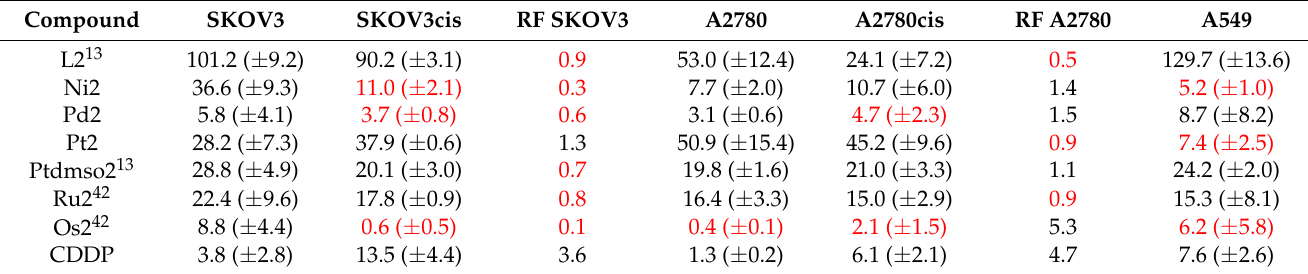
Table 6. IC 50 values [ µ M] for ovarian cancer cell lines and lung cancer cell line A549 for all 2 compounds